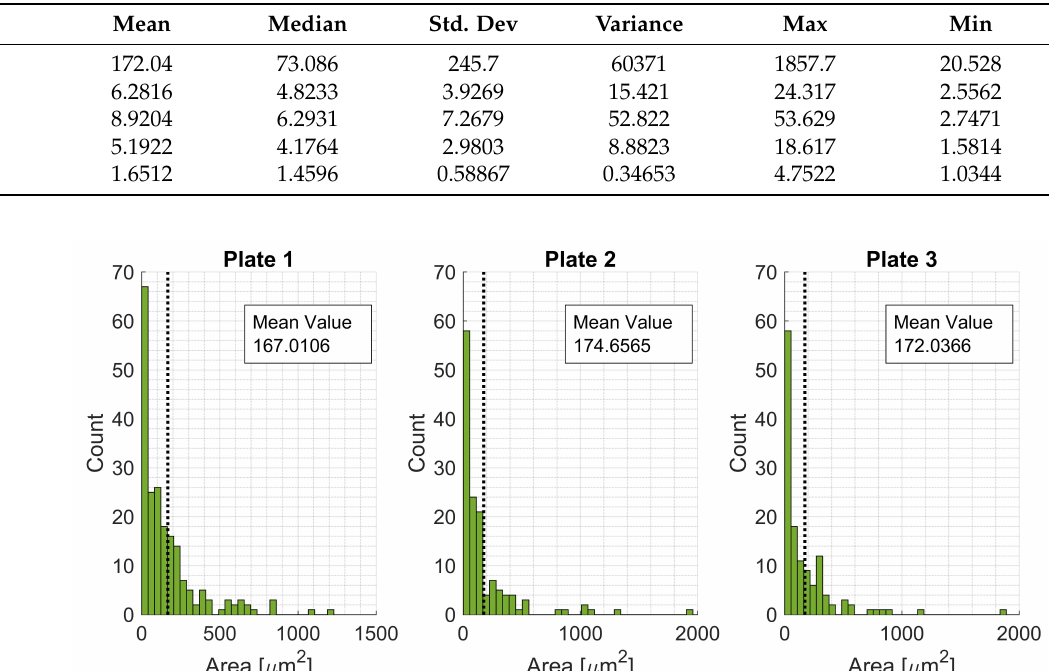
Figure 12. Histograms for void areas for Plates 1, 2, and